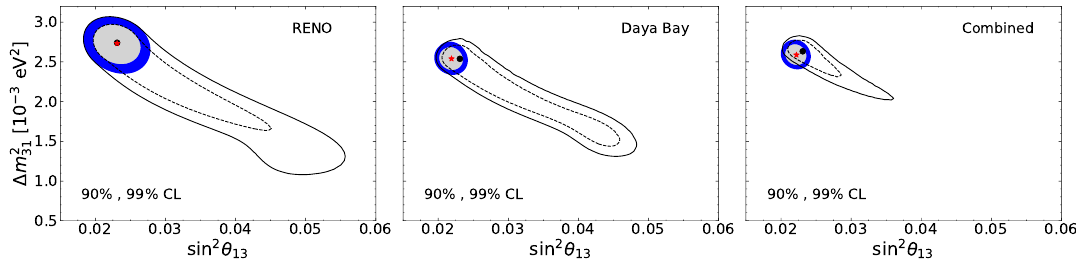
Figure 2 . 90 and 99% CL (2 d.o.f.) allowed regions in the sin 2 (cid:18) 13 -(cid:1) m 2 Daya Bay (center) and the combination of both experiments (right). Filled regions correspond to the analyses assuming a perfectly coherent source, while black lines are obtained after marginalizing over (cid:27) . The best-(cid:12)t points from the standard analyses are indicated with a red star, while the best-(cid:12)t values from the analyses including (cid:27) are denoted by black dots.